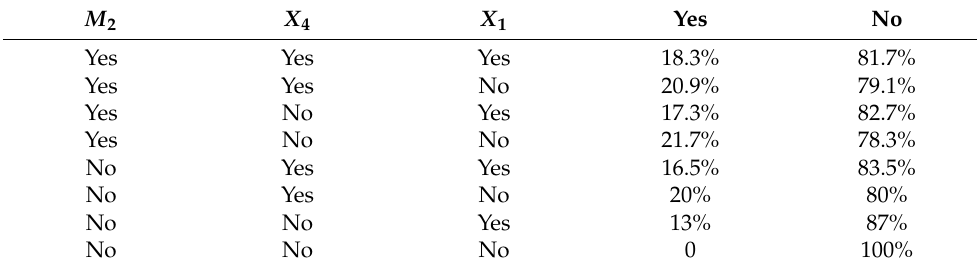
Table A8. Conditional probability distribution of M 1 .